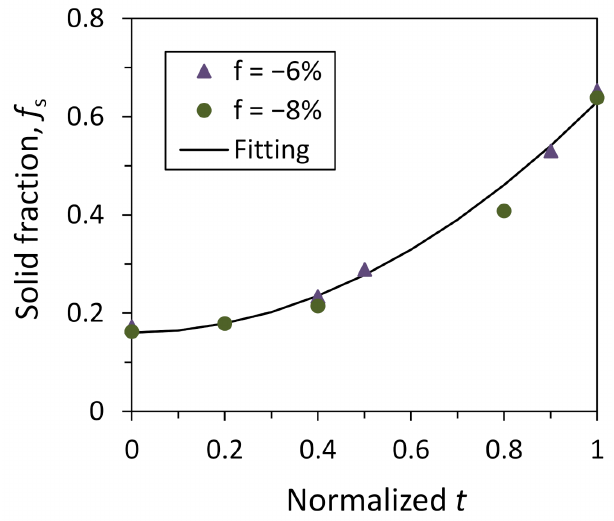
Figure 20. Evolution of atomic ordering during heterogeneous nucleation. Fraction of solid atoms ( f s ) in the 9 layers of atoms above the substrate is plotted as a function nucleation time ( t ) normalised by the nucleation finish time ( t 2 ) for the systems with − 6% and − 8% misfit. For a good approximation, the data can be fitted as the fraction of solid atoms f s = 0.16 + 0.47 t 2